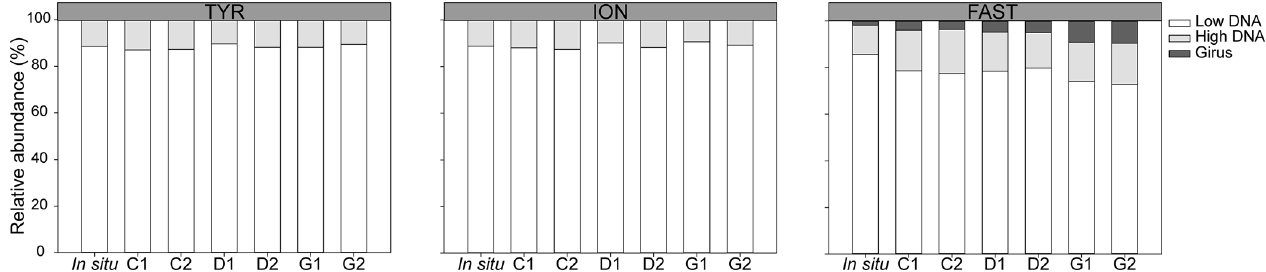
Figure 3. Relative abundance of viral populations at the initial (in situ at t12h before dust addition) and final time points in all minicosms (C1, C2, D1, D2, G1, and G2) during the three experiments (TYR, ION, and FAST).